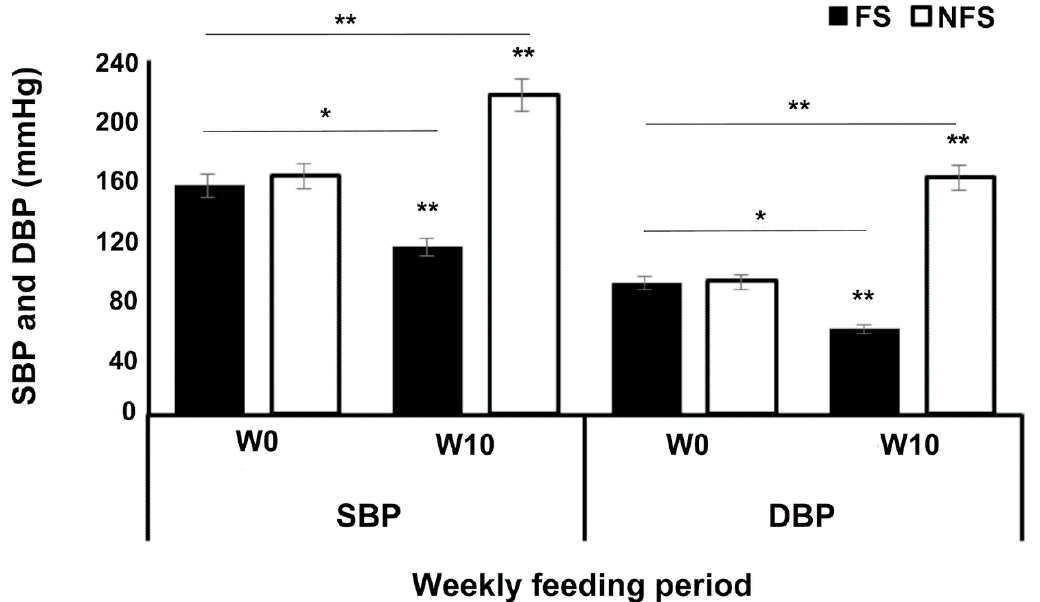
Figure 4. Systolic blood pressure (SBP) and diastolic blood pressure (DBP) of spontaneously hyper- tensive rats (SHR). Oral administration (10 weeks) of fermented skim milk containing peptides (FS) compared with skim milk powder as control (NFS). Error bars represent standard error of the means (±SEM). * p < 0.05, ** p < 0.01.